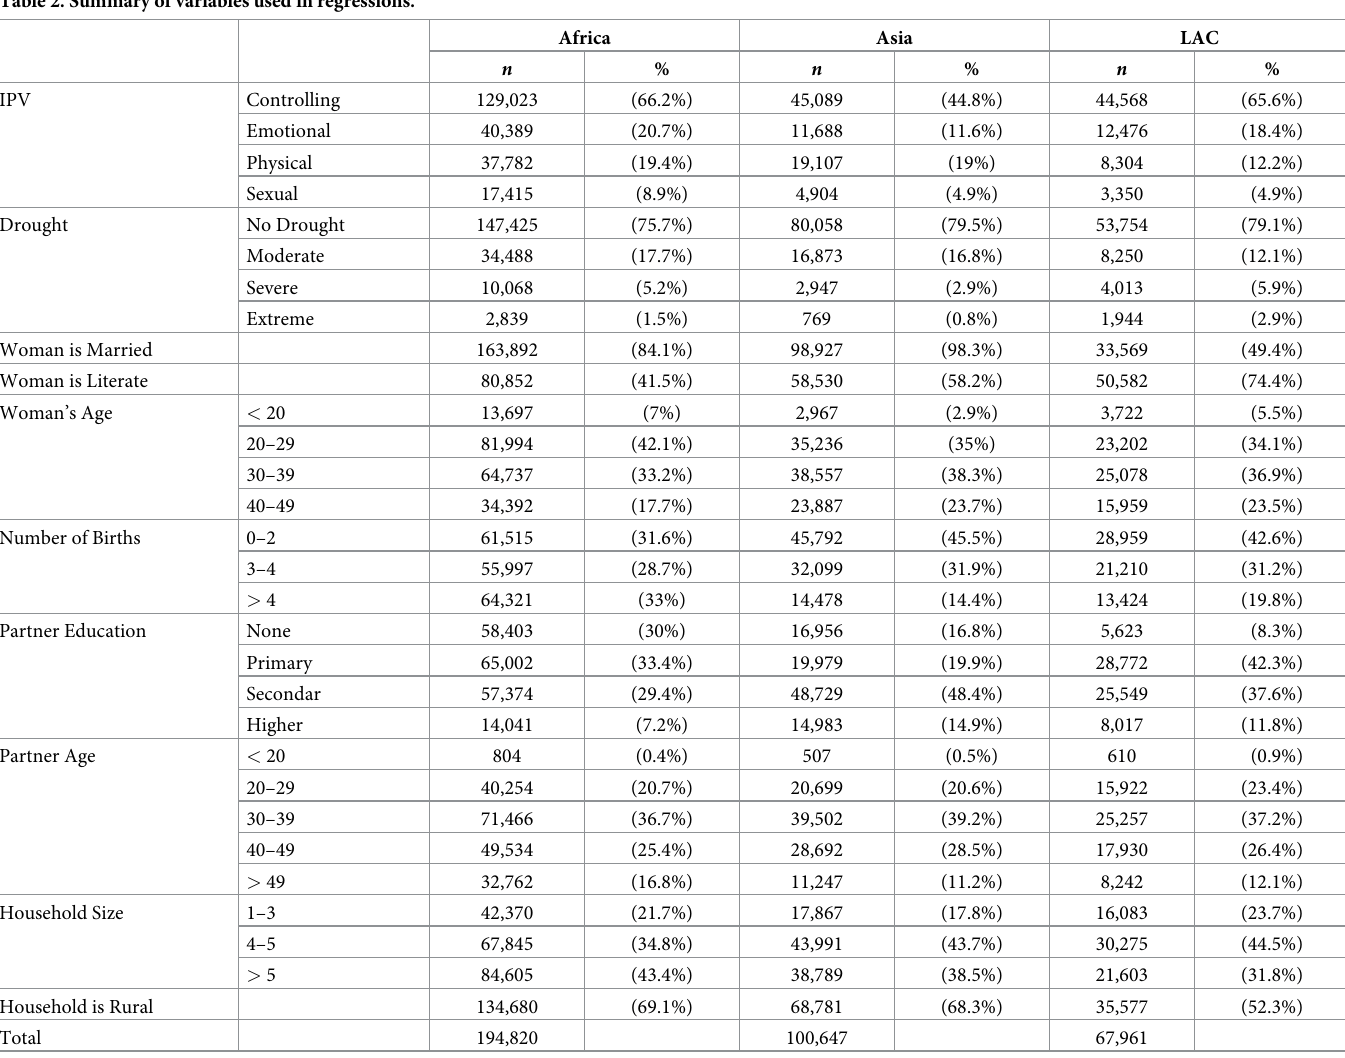
Table 2. Summary of variables used in